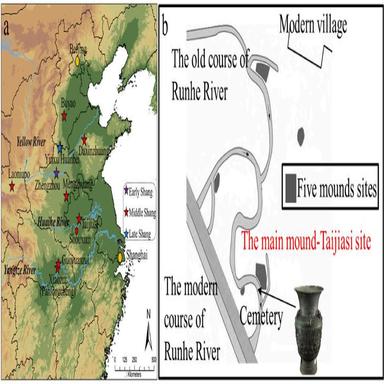
a): Location of the Taijiasi site and other sites dated to the Shang period where ceramic moulds, cores, or models for bronze vessel were unearthed; b): The Taijiasi site and the location where bronze vessels were discovered in Runhe River.